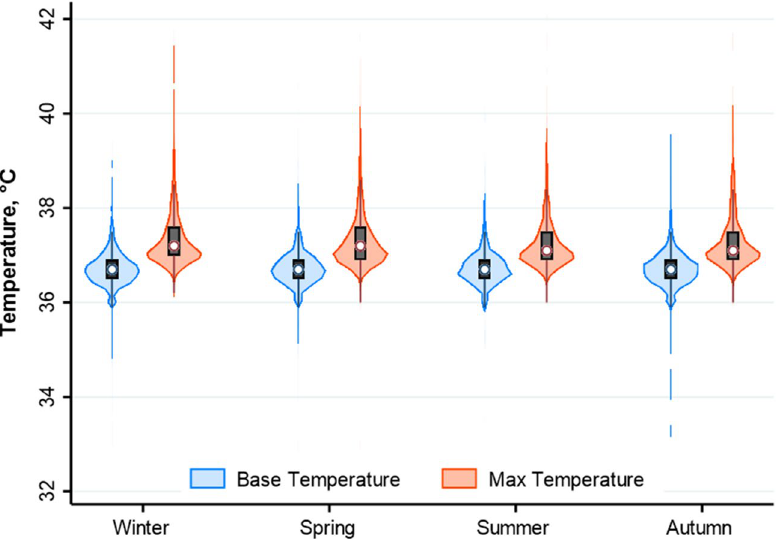
Figure 3. Violin plots of the distribution of baseline temperature and maximal temperature by season. The shape of the violin is the mirrored frequency distribution of the data. Medians are marked by the white dot, and the interquartile range is marked by a vertical black bar, and thin black lines denote the lower and upper